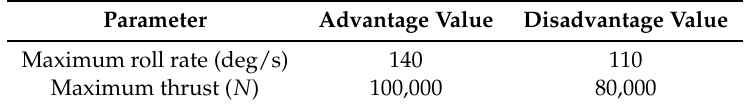
Table 1. Unmanned combat air vehicles (UCAV) performance parameters